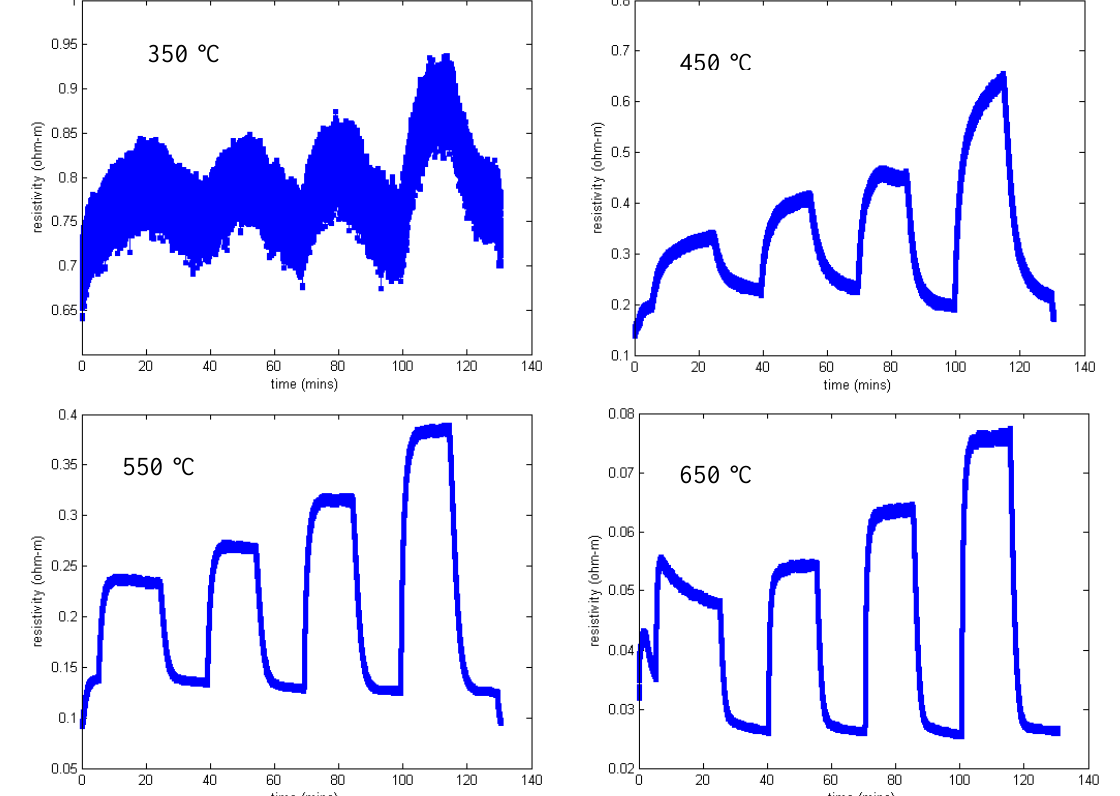
Figure 19. Resistivity measurements of SnO time. Each plot shows the resistivity as a function of time when the oxygen concentration is varied according to Figure 11.